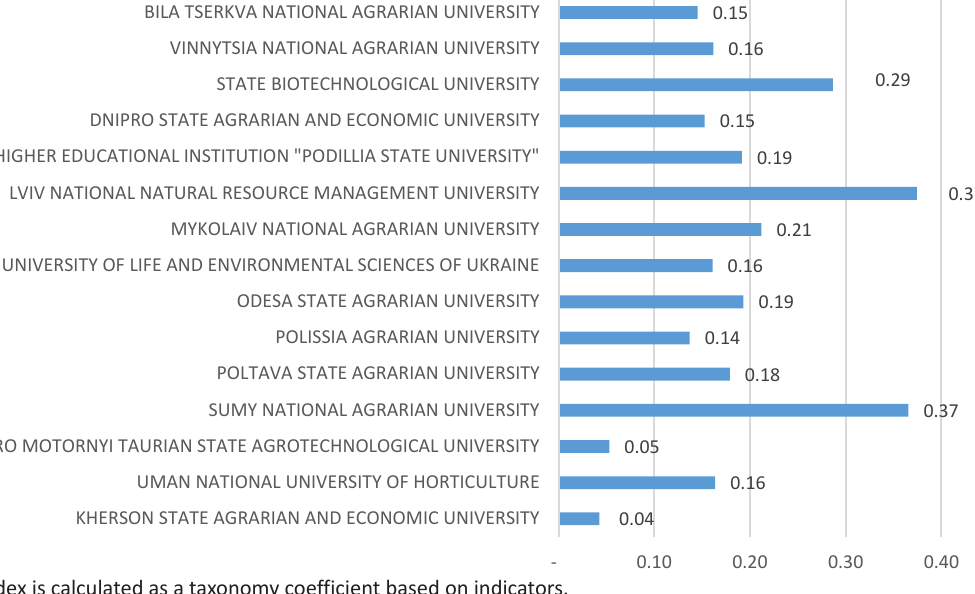
Figure 2. University Integral Sustainability